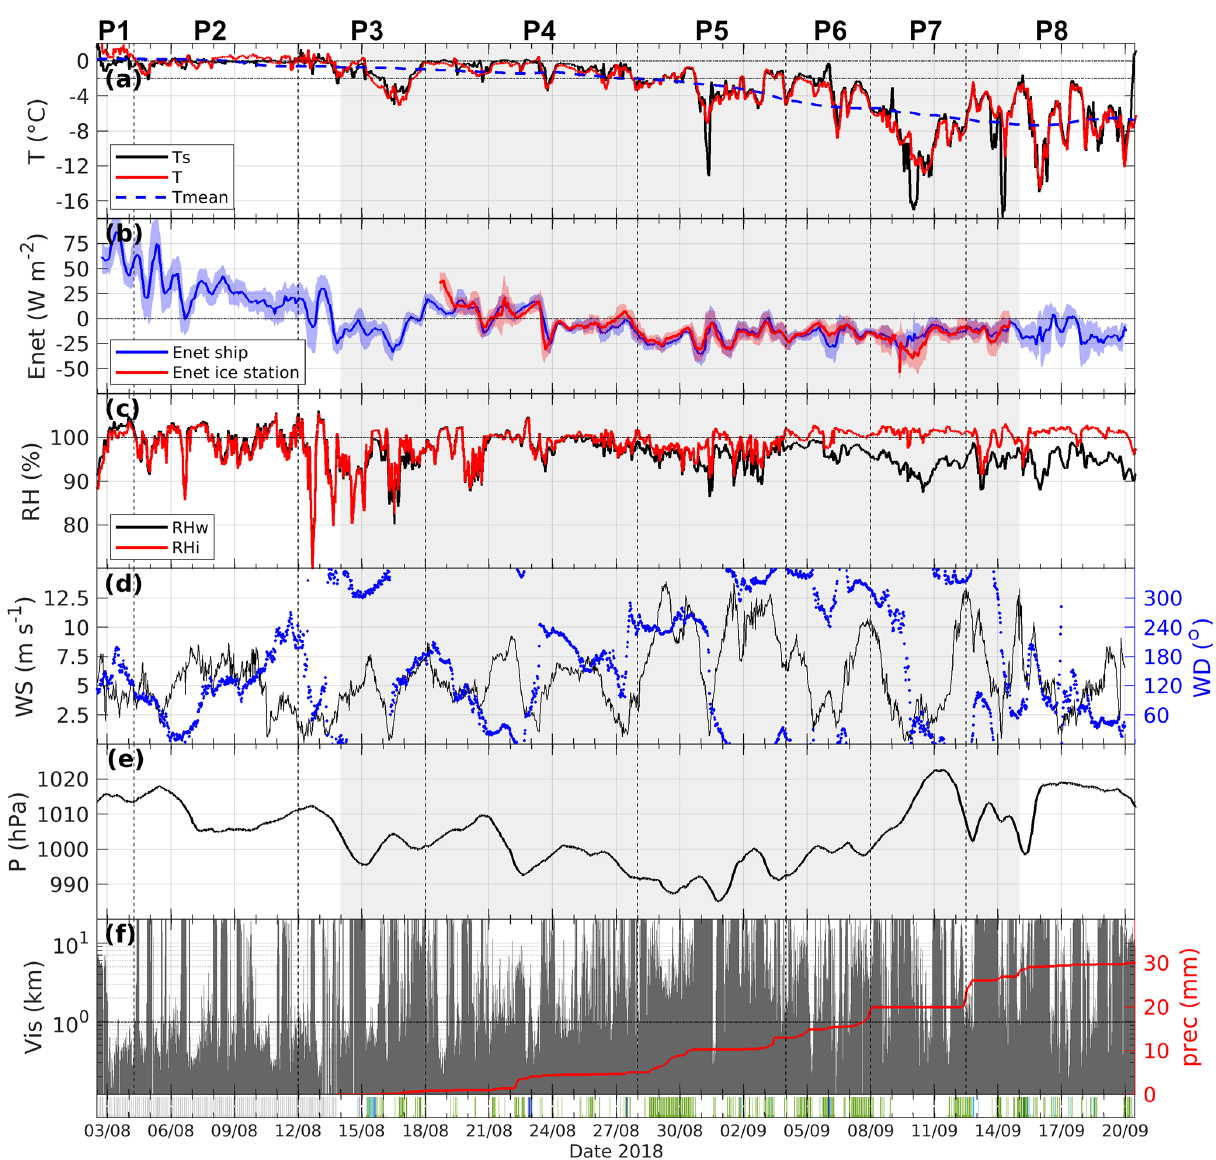
Figure 5. Time series of (a) surface temperature, near-surface air temperature, and 14d running mean of near-surface temperature; (b) 12h running mean of surface energy ± 1 standard deviation (shaded area); (c) RHw and RHi; (d) wind speed and wind direction; (e) air pressure; (f) visibility, accumulated precipitation and precipitation type. Data in panels (a) , (c) , (e) , and (f) are from instruments installed on the seventh deck of the ship. Turbulent fluxes for calculation of panel (b) and wind measurements are from the foremast of the ship. Net radiation for calculation of (b) is from measurements on the ship (blue line) and the station on the ice floe (red line). Vertical dashed lines mark the identified key periods P1 to P8, and the grey shaded area represents the drift period. The precipitation type in panel (f) is colour coded. Grey is missing data, blue is drizzle and rain, and green is snow and